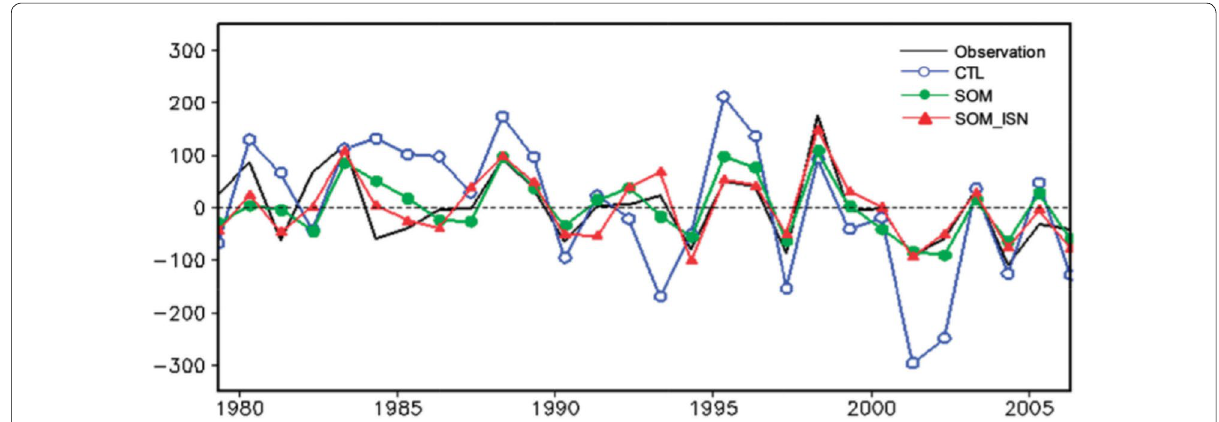
Fig. 3 Corresponding PC time series of the first model eigenvector from the empirical orthogonal function (EOF) analysis of seasonal mean precipitation related to the interannual variability of the EASM. The temporal correlation coefficient between observation and the CTL experiment is 0.57, while that between observation and the SOM experiment is 0.71 (adapted from Cha et al. (2016a, b))